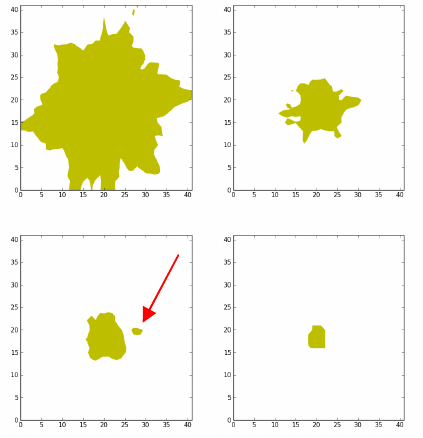
Figure 15 : Sirius sections at levels [40, 530,820,4095]